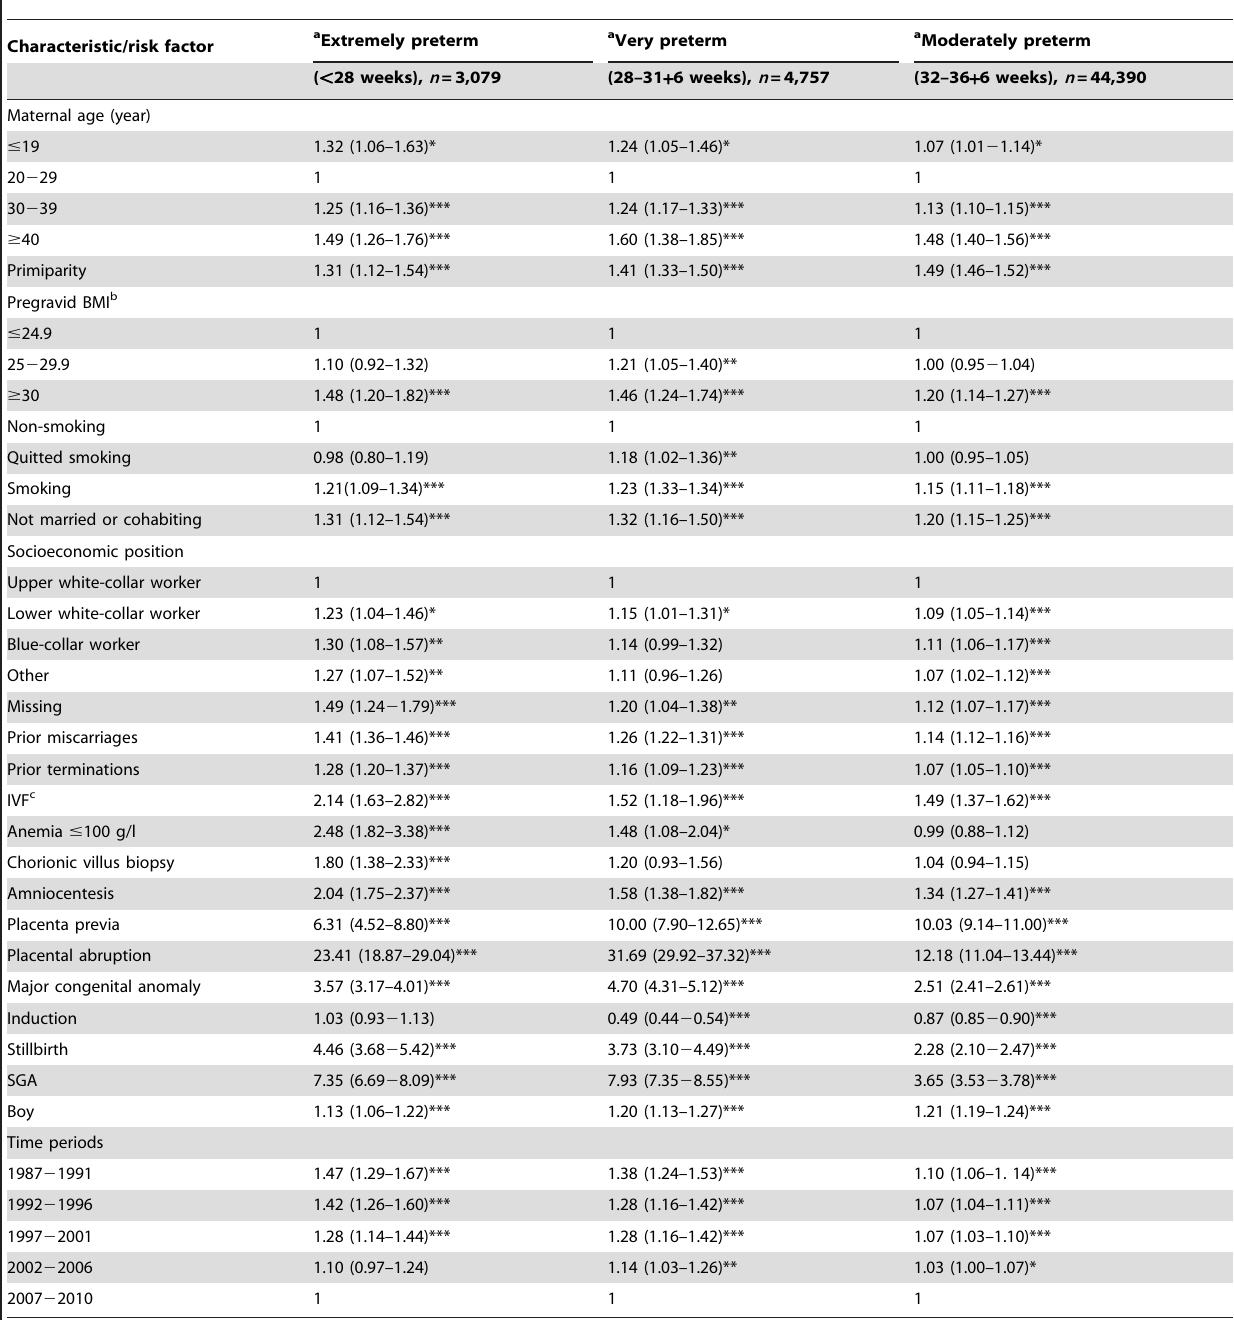
Table 2. Adjusted odds ratios (aORs) of singleton extremely preterm, very preterm and moderately preterm births for the years 1987–2010 in